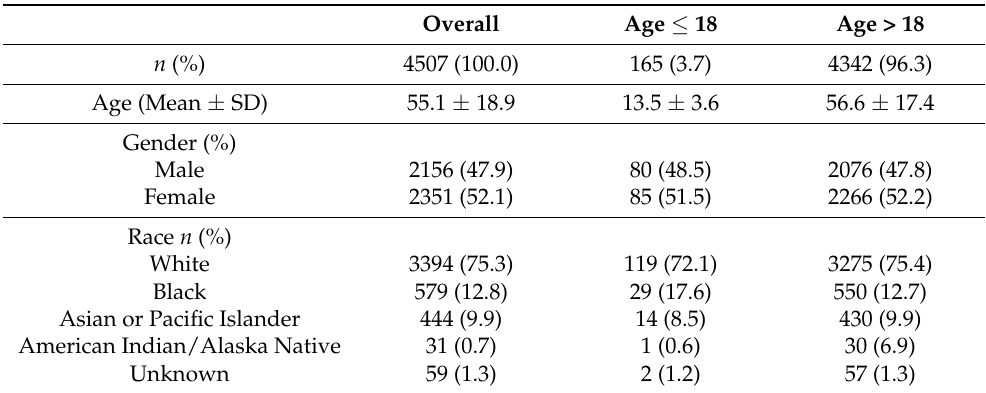
Table 1. Demographics and Clinical Profile of 4507 Patients with Mucoepidermoid Carcinoma (MEC) from the Surveillance Epidemiology and End Result (SEER) Database (2000–2018). Patients are divided into two main groups: pediatric ( ≤ 18 years old) and adult (>18 years old). The overall survival, gender differences and racial disparities are compared both in pediatric and adult groups. Overall Age ≤